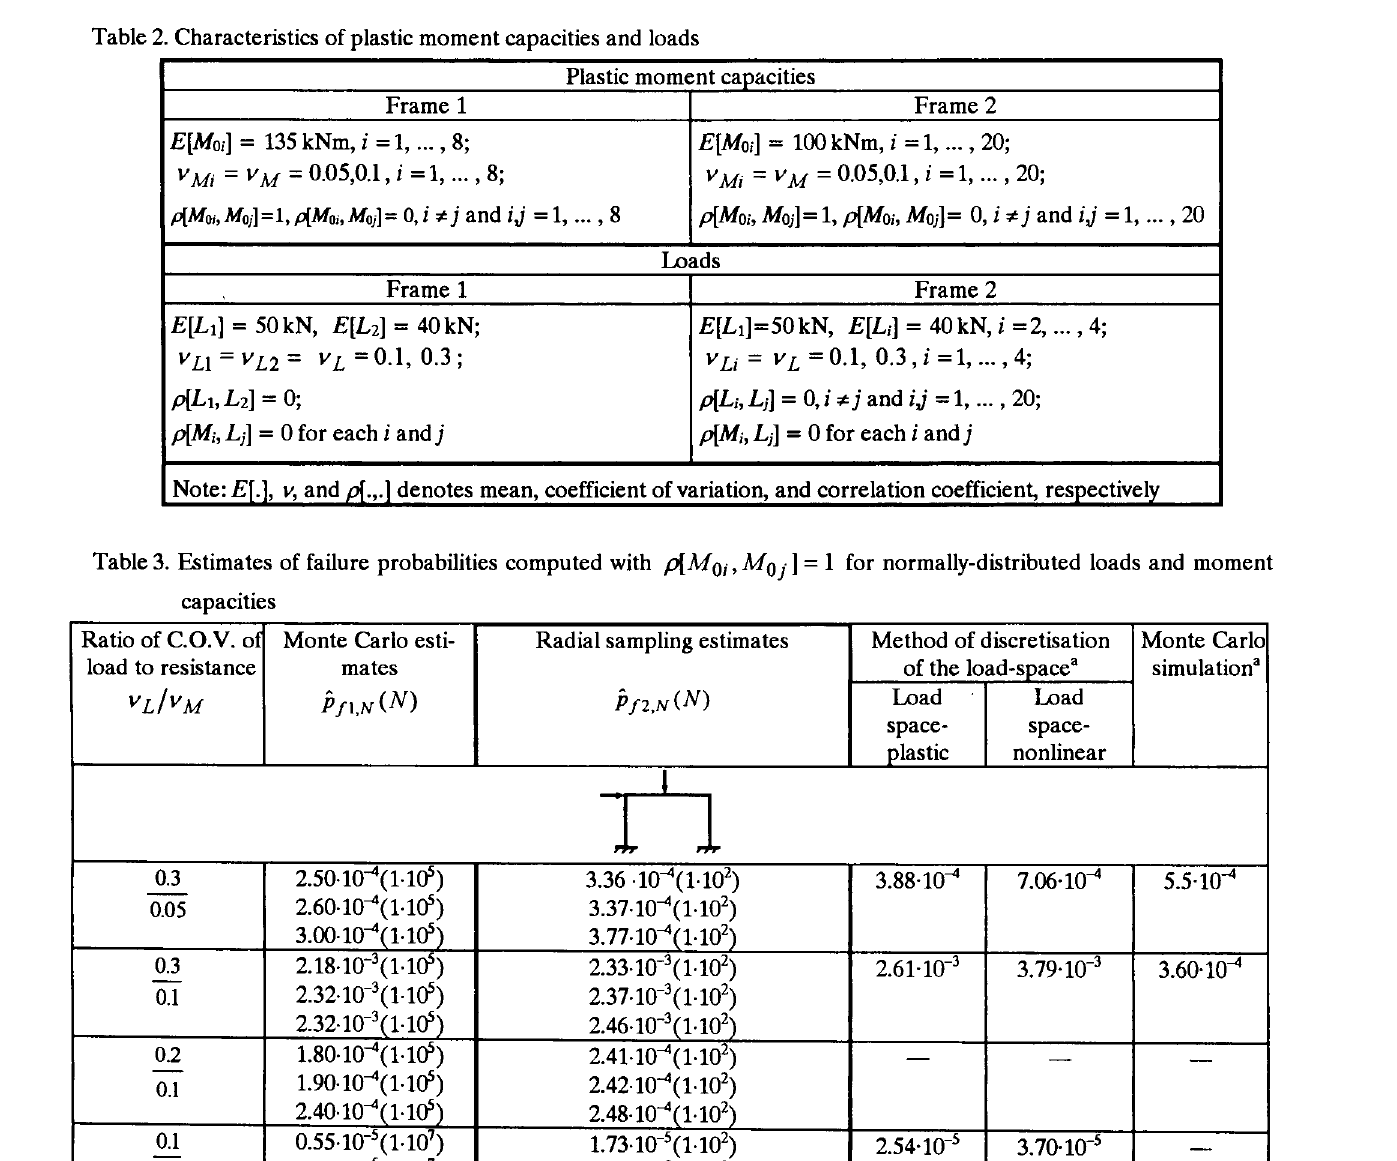
Table 2. Characteristics of plastic moment capacities and loads Plastic moment capacities Frame 1 Frame 2 E[Mo;] = 135 kNm, i = 1, ... , 8;